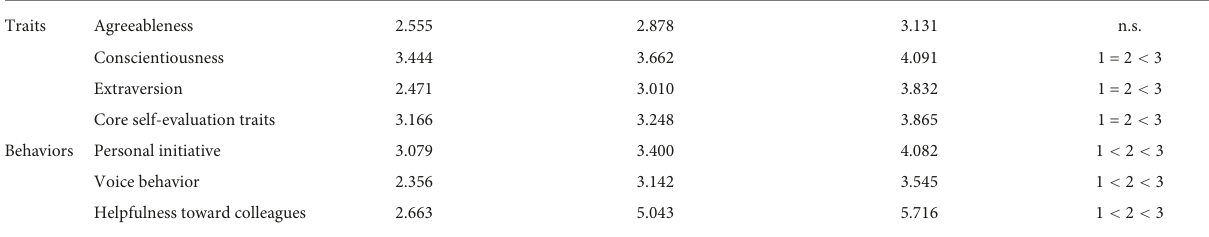
TABLE 3 Differences in means for traits and behaviors of the three latent profiles ( t 1 ).